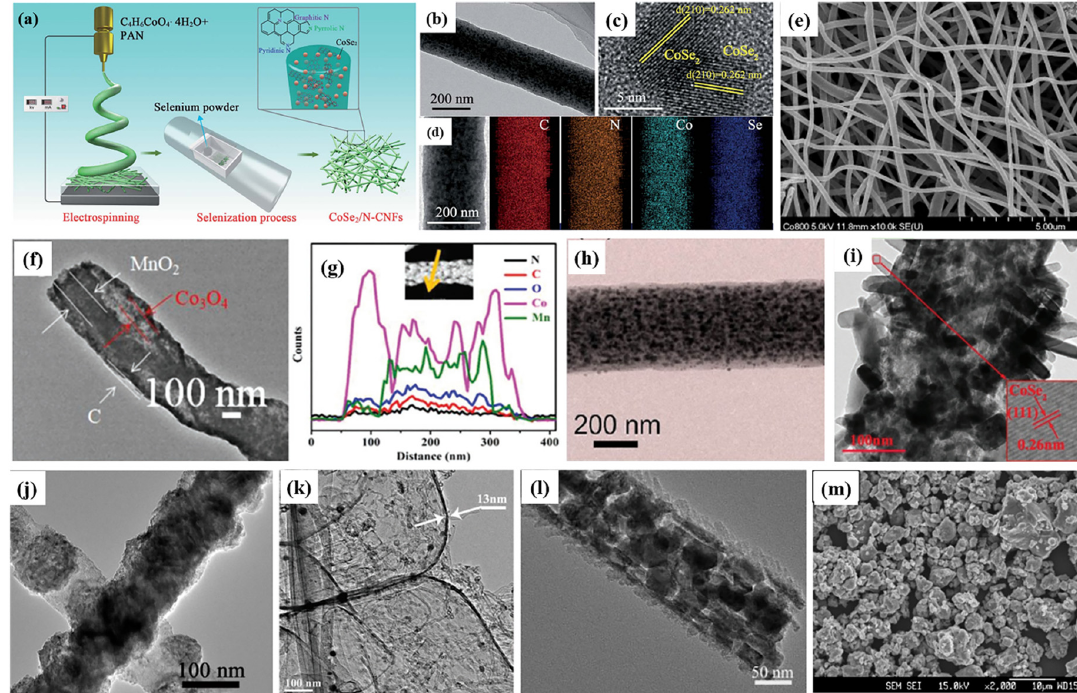
Figure 8. Preparation methods and morphology characterizations of cobalt-based composites. ( a ) Schematic illustration of the preparation of CoSe 2 / N-carbon nanofibers (CNFs). ( b ) TEM image, ( c ) HRTEM image and ( d ) elemental mapping images of CoSe 2 / N-CNFs [24]. ( e ) SEM image of Co-Sn / CNFs at 800 ◦ C [90]. ( f ) TEM image and ( g ) HAADF-STEM-EDS line-scanning elemental mapping of Co 3 O 4 / MnO 2 @C [91]. ( h ) TEM image of SnCo / PAN-CNFs [92]. ( i ) HRTEM image is taken from the selected zone [93]. ( j ) TEM image of Co / Co 3 O 4 -CNFs-700 [94]. ( k ) TEM image of the SnCo@CNT-3DC composite [44]. ( l ) SEM image of Co 3 O 4 nanowire arrays [95]. ( m ) SEM image of the Co 2 MnSi powder